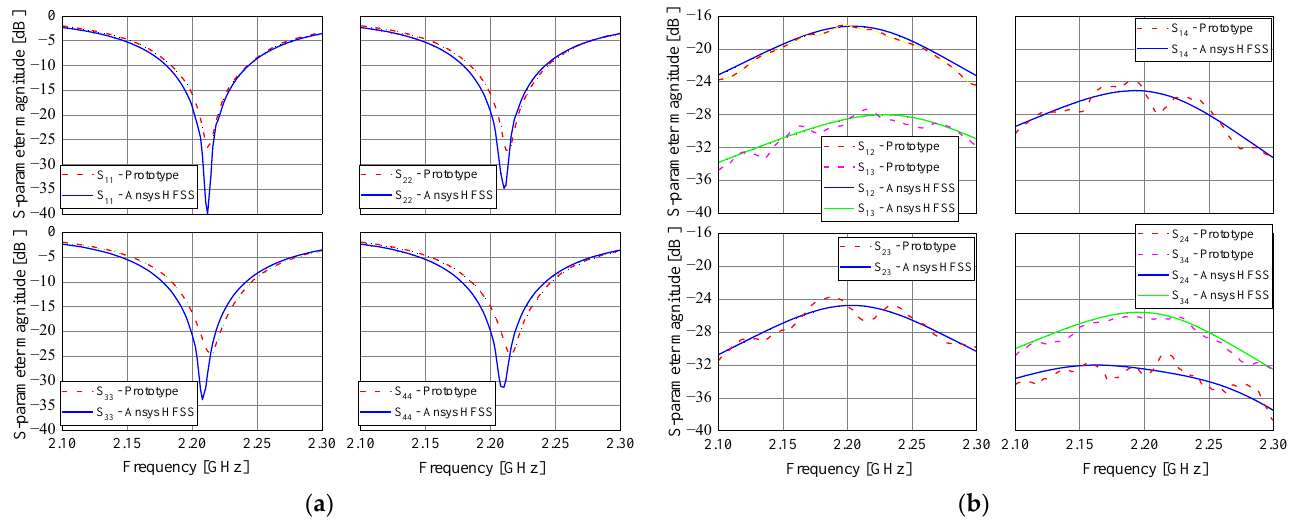
Figure 7. Simulated and measured 𝑆 parameters of the microstrip antenna array: ( a ) 𝑆 𝑛𝑛 ; ( b ) 𝑆 𝑚𝑛 .